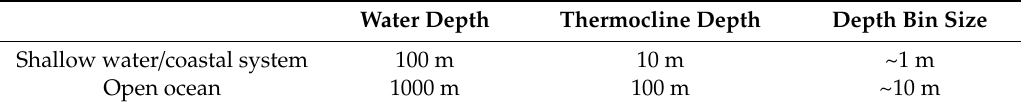
Table 4. Brief scale analysis of thermocline depth range and depth bin